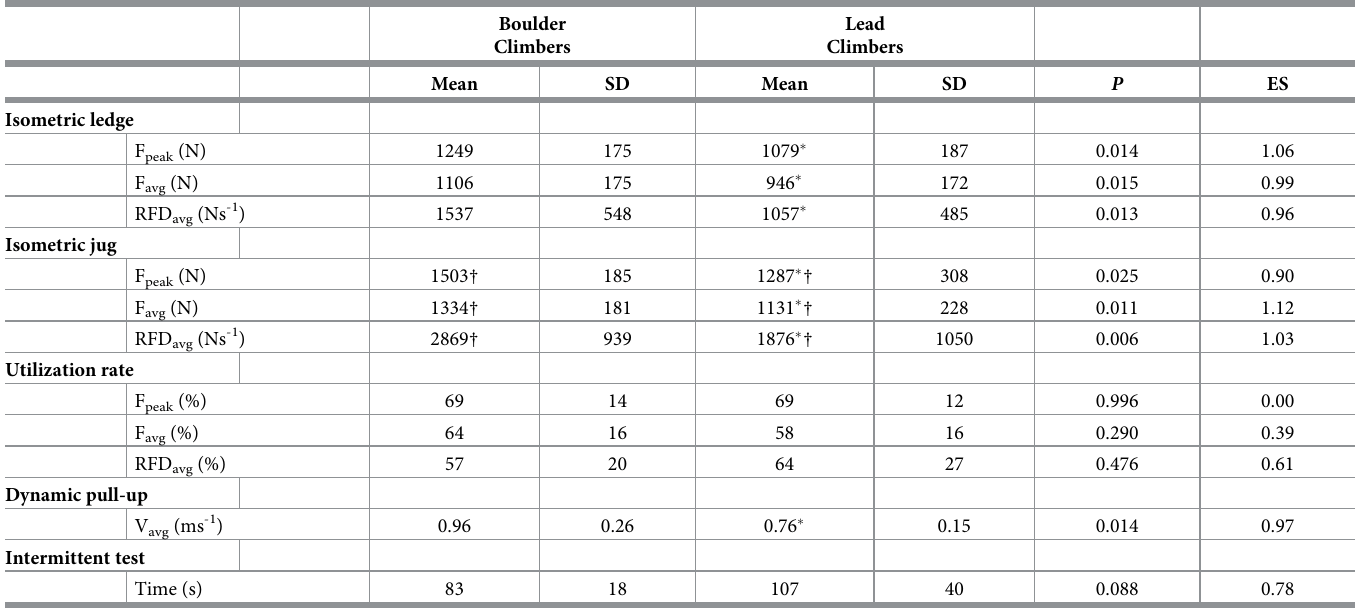
Table 2. Absolute values from the dynamic and isometric pull-up and the forearm endurance test.